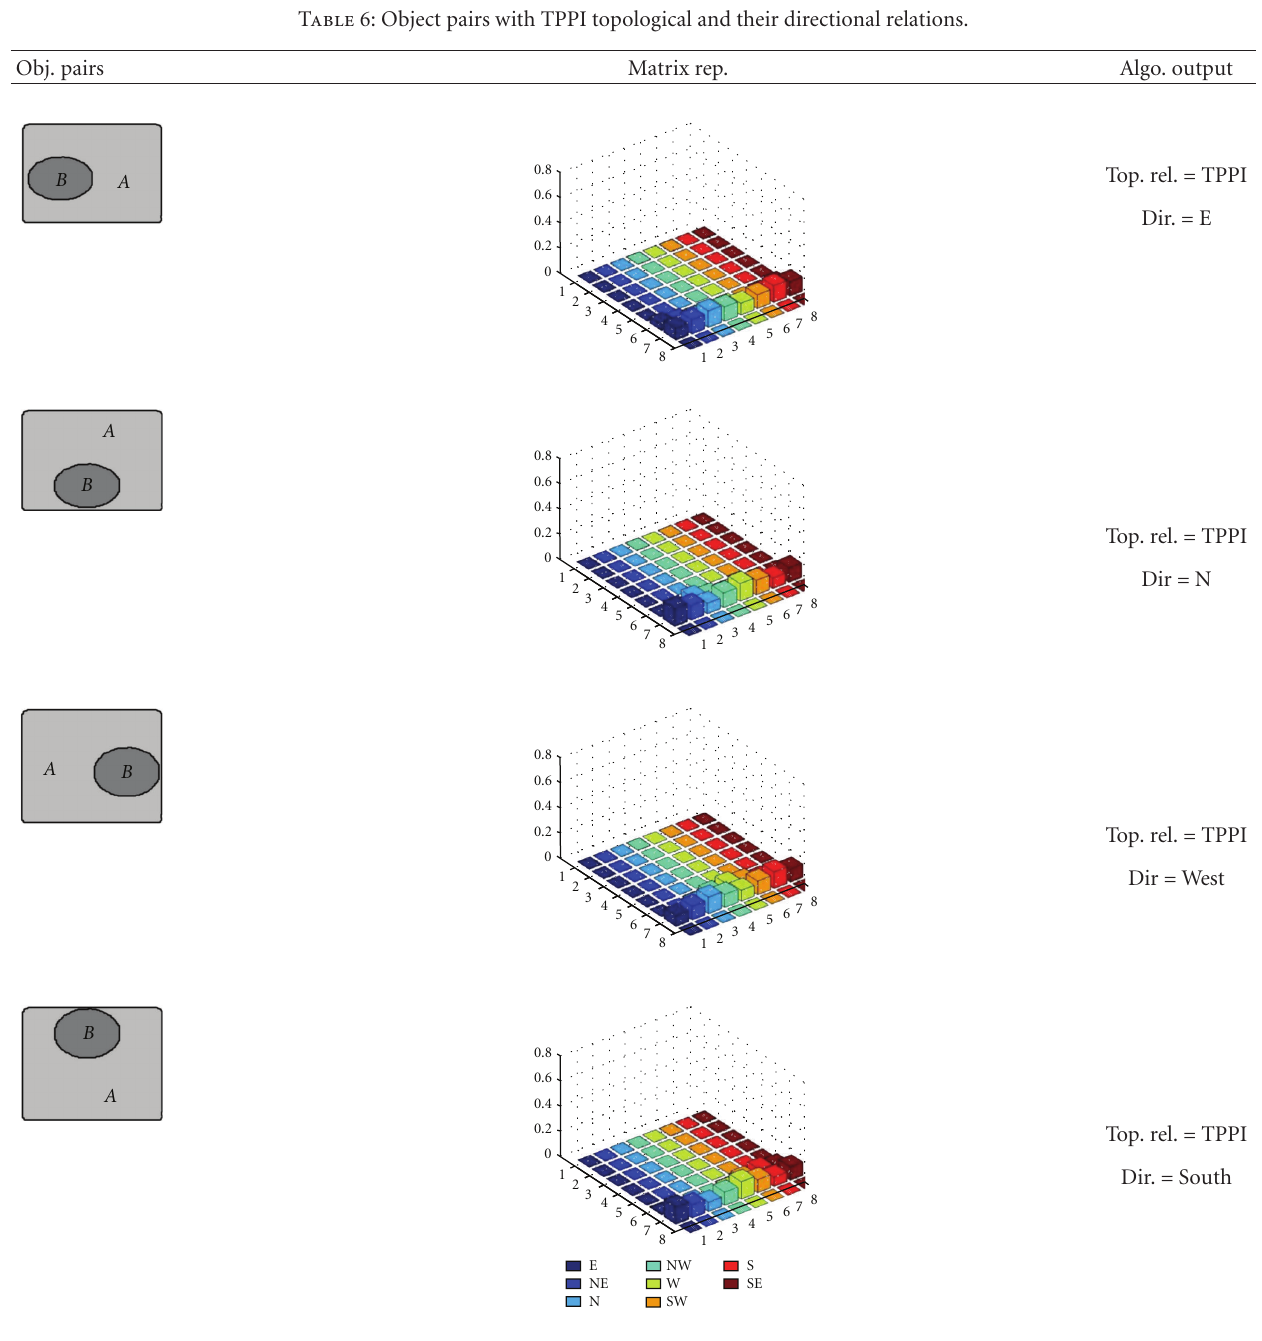
Top. rel. = TPPI Dir. =